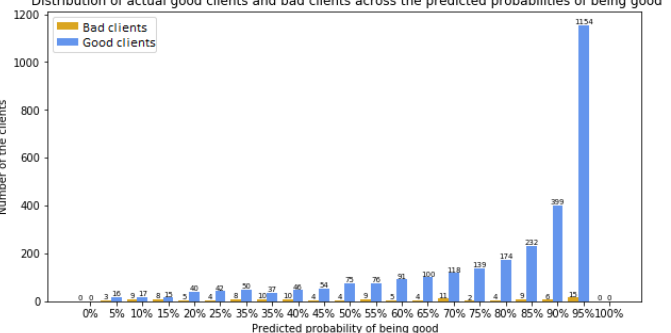
Figure 1. Distribution of good and bad customers with a least squares fuzzy SVM model.